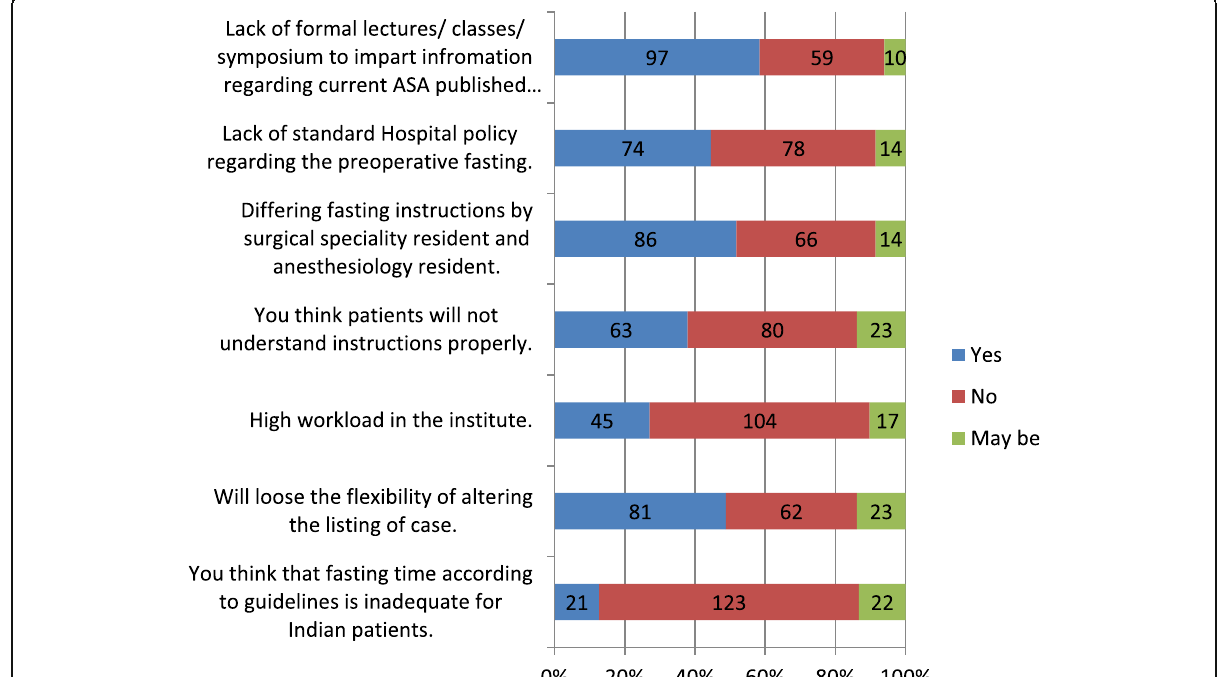
Fig. 4 Summary of perceived limiting factors with respect to implementation of ASA published guidelines pertaining to preoperative